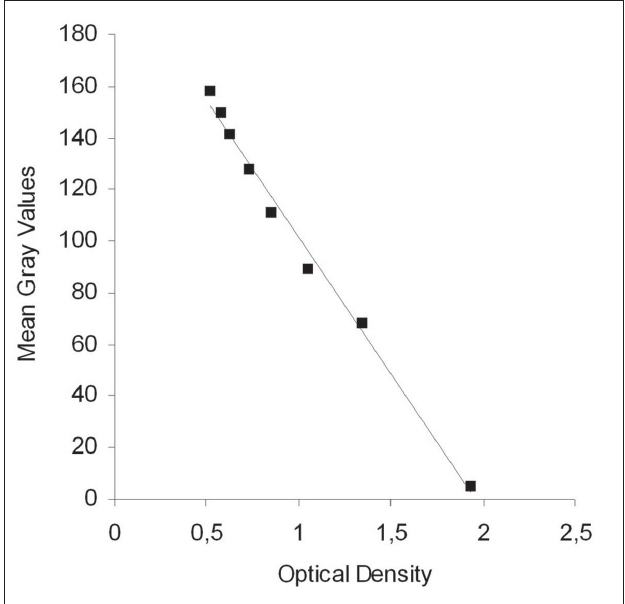
Fig. 1 – Conversion of optical density values into mean gray values. (y = -105,67x + 207,12 and R 2 =